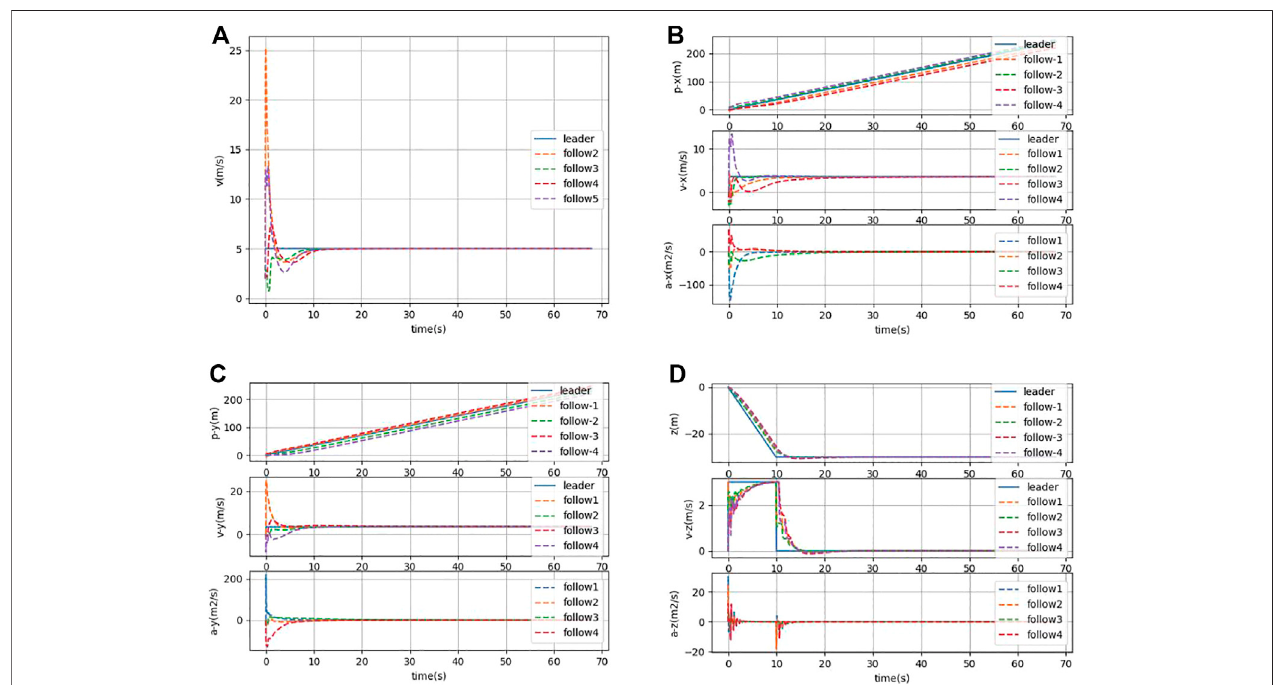
FIGURE 6 | (A) Combined velocity in the x , y , and z directions under communication delay. (B) Position, velocity, and acceleration states in the x -direction under communicationdelay. (C) Position,velocity,and acceleration statesinthe y -directionundercommunicationdelay. (D) Position, velocity,and acceleration statesinthe z - direction under communication delay.